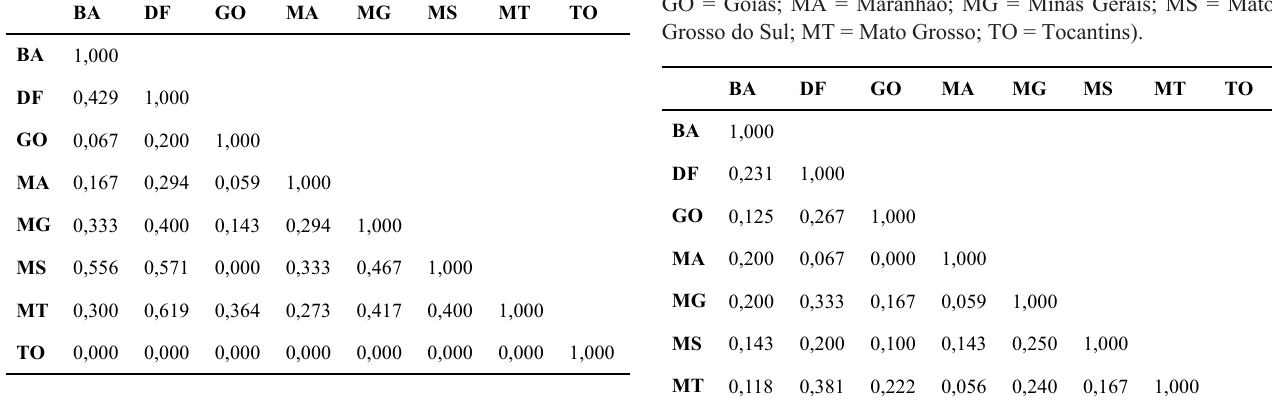
Table 4. Similarity matrix (Jaccard) of species from the Polistes genus for the 8 studied states (BA = Bahia; DF = Distrito Federal; GO = Goiás; MA = Maranhão; MG = Minas Gerais; MS = Mato Grosso do Sul; MT = Mato Grosso; TO = Tocantins).